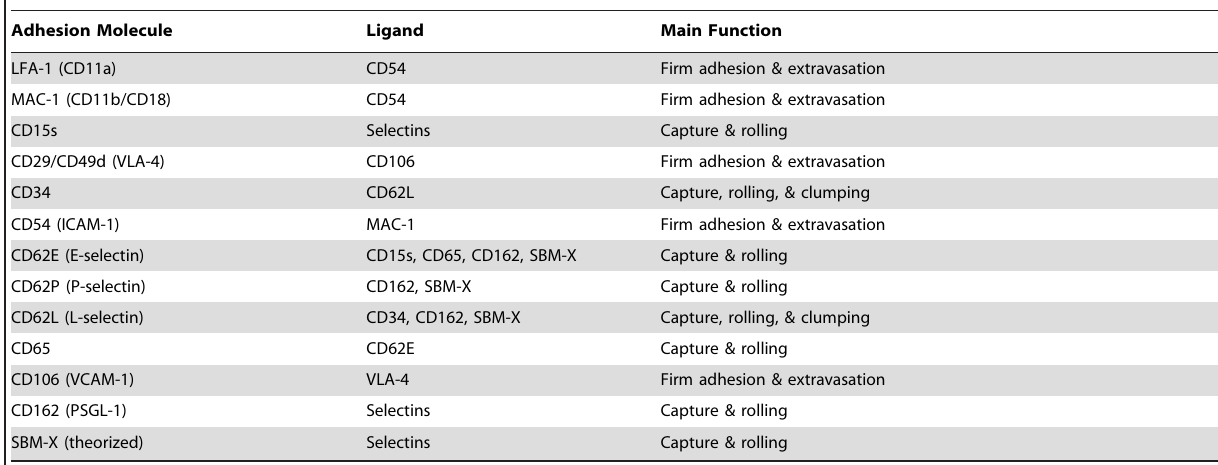
Table 3. In Silico receptor-ligand pairs and